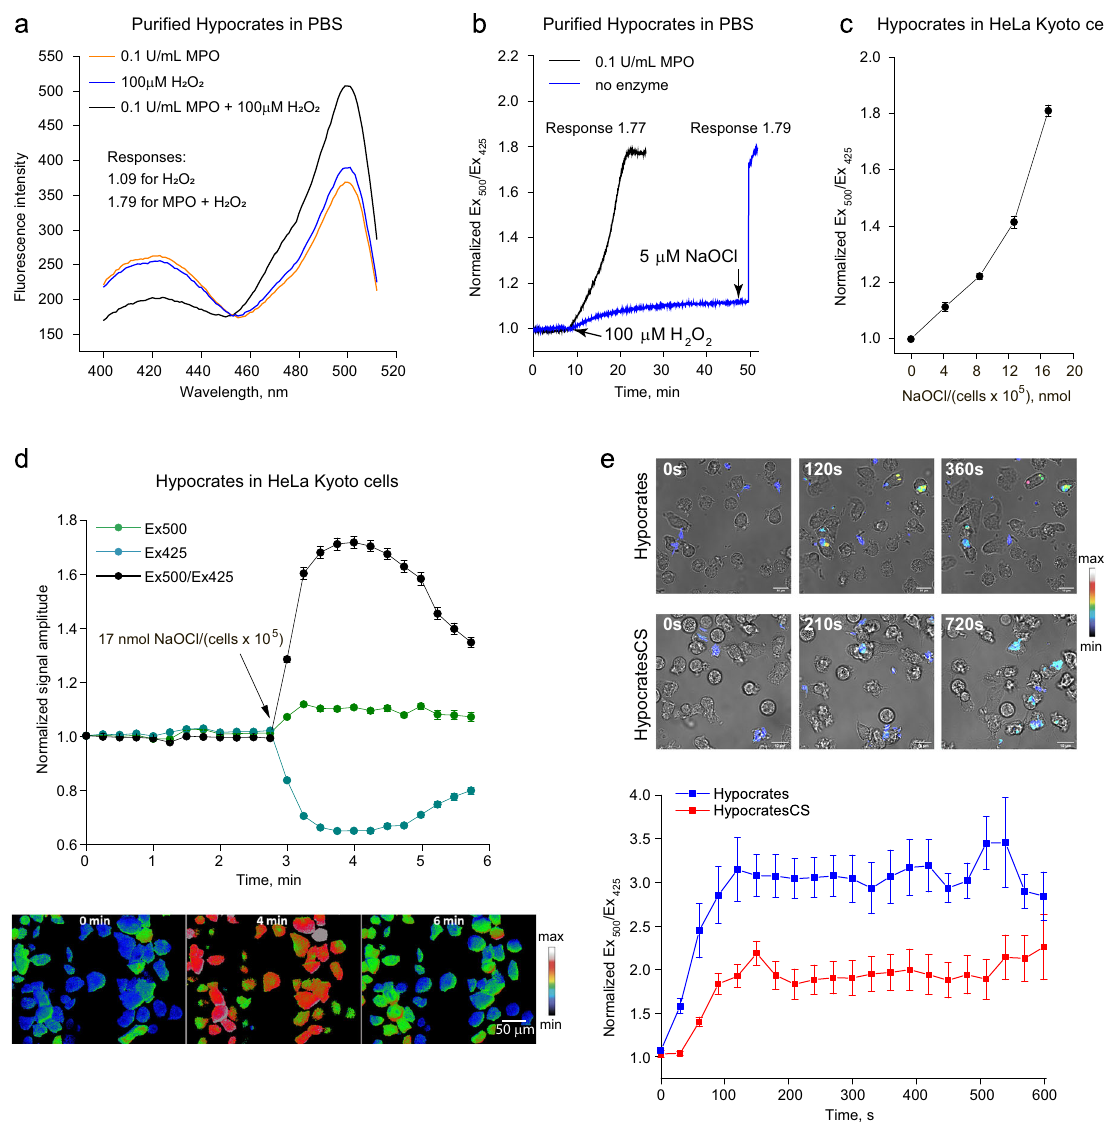
Fig. 5 Hypocrates performance in vitro and in eukaryotic cell culture. a Fluorescence excitation spectra of puri fi ed Hypocrates (0.5 µ M) in the presence of individual myeloperoxidase (MPO), H 2 O 2 and the MPO-H 2 O 2 system. b Hypocrates (0.5 µ M) signal as a function of time in the presence of individual H 2 O 2 and the MPO-H 2 O 2 system. HOCl, generated by MPO, leads to the development of a saturating response, while a physiologically irrelevant H 2 O 2 concentration induces only minor signal changes. c The titration curve of Hypocrates in HeLa Kyoto cells exposed to different concentrations of NaOCl (values ± SEM, N = 2 experiments, n ≥ 25 cells per experiment). d Upper part: Hypocrates fl uorescence changes induced by 17 nmol NaOCl/(10 5 cells) (values ± SEM, N = 2 experiments, n ≥ 30 cells per experiment). Lower part: Images of Hypocrates in transiently transfected HeLa Kyoto cells exposed to 17 nmol/(10 5 cells) NaOCl at different time points. Scale bar = 50 µ m. The lookup table indicates changes in the Ex 500 /Ex 425 ratio. e Upper part: Images of human neutrophils phagocytosing E. coli cells that express Hypocrates or the control version HypocratesCS. Scale bar = 10 µ m. The lookup table indicates changes in the Ex 500 /Ex 425 ratio. Lower part: Hypocrates (blue line) and HypocratesCS (red line) fl uorescence changes in E. coli cells phagocytosed by human neutrophils. The starting point on the graph corresponds to the moment at which individual bacteria are phagocytosed by a neutrophil (values ± SEM, N = 3 experiments, 35 bacterial cells in total for each version of the sensor). Source data are provided as a Source Data fi